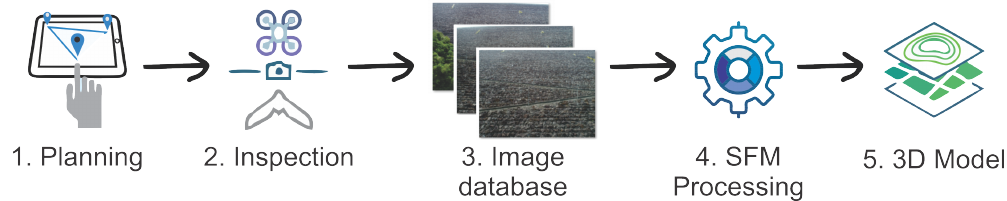
Figure 6. Aerial photogrametry inspection process.